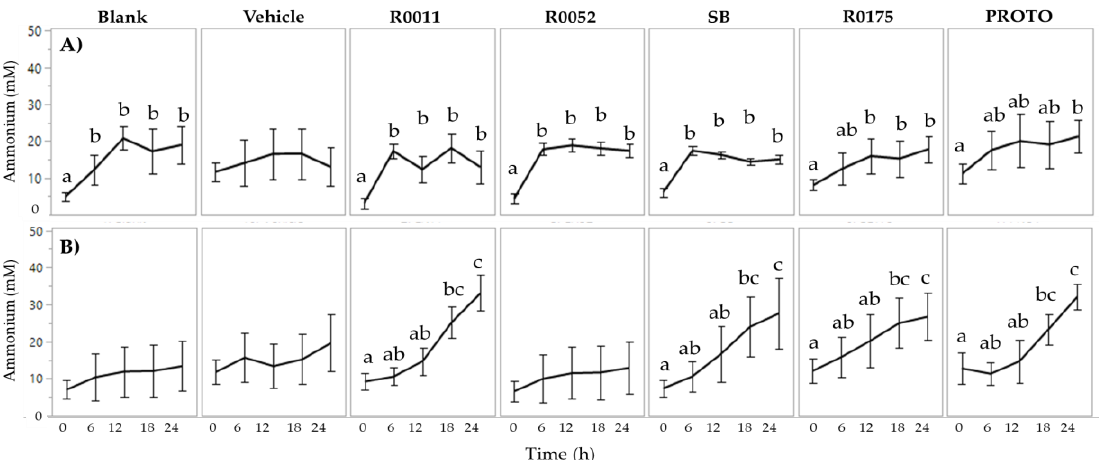
Figure 3. Determination of ammonium in fecal water (FW); ( A ) Normal FW and ( B ) Clostridium ( C. ) difficile -infected FW. Values are shown as mean ± SEM. Means at time points within treatments without a common letter are significantly different ( p < 0.05). R0011 = L. rhamnosus R0011; R0052 = L. helveticus R0052; SB = S. boulardii CNCM I-1079; R0175 = B. longum R0175; PROTO = ProtecFlor TM .